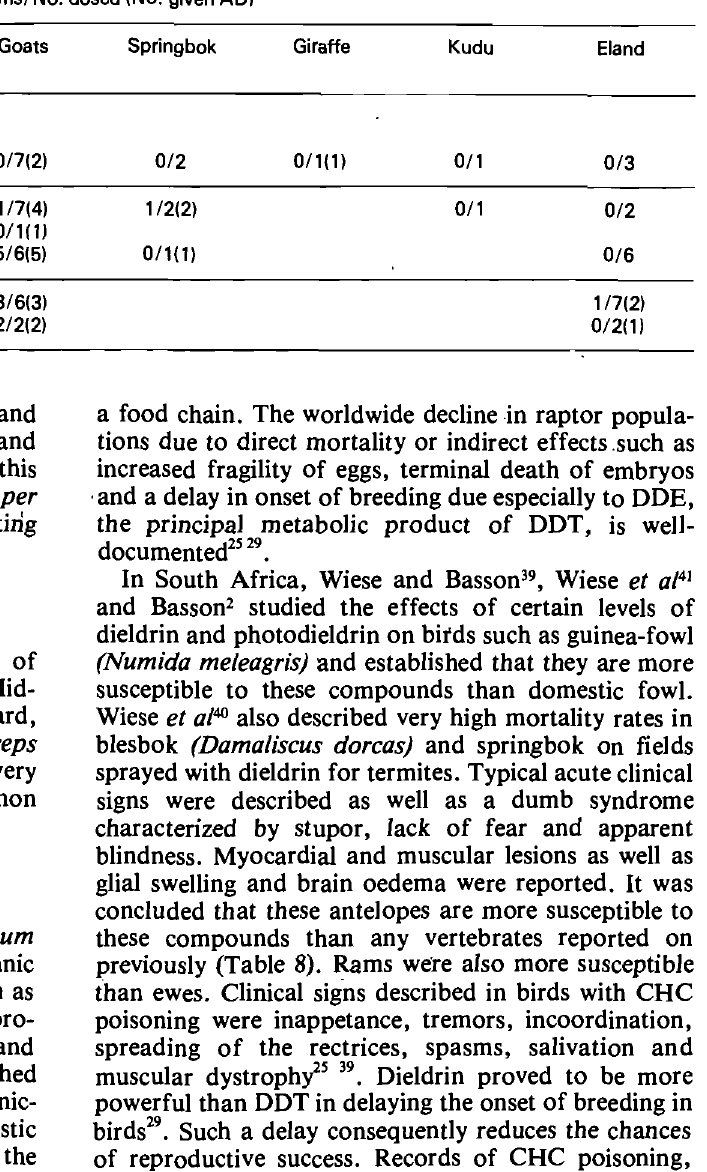
Table 5: Number of animals experimentally dosed with potassium cyanide powder which showed spasms and number which were given antidotes (AD) No. with spasms/No. dosed (No. given AD) Dosage